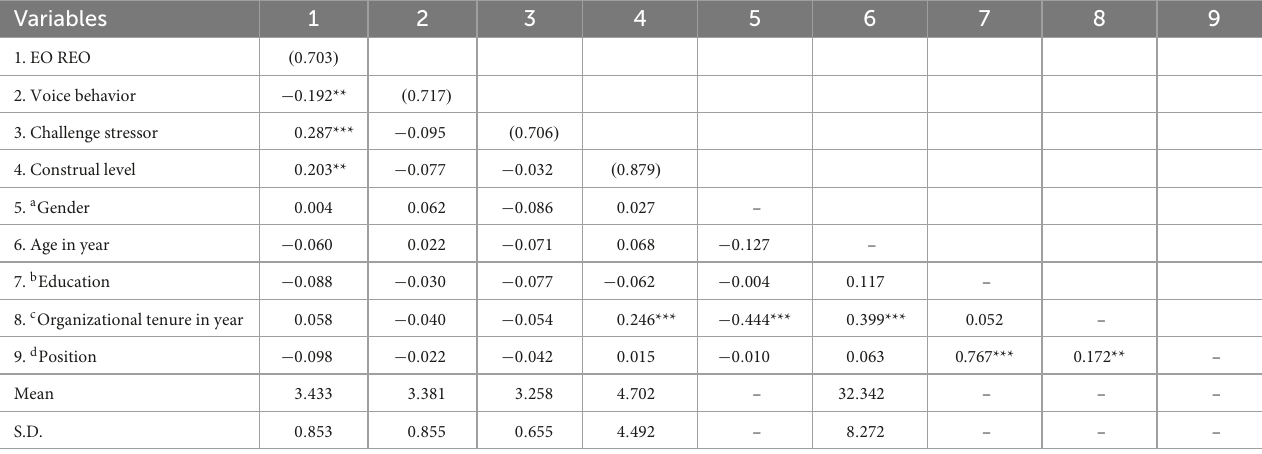
TABLE 3 The correlations between the variables in study 2.